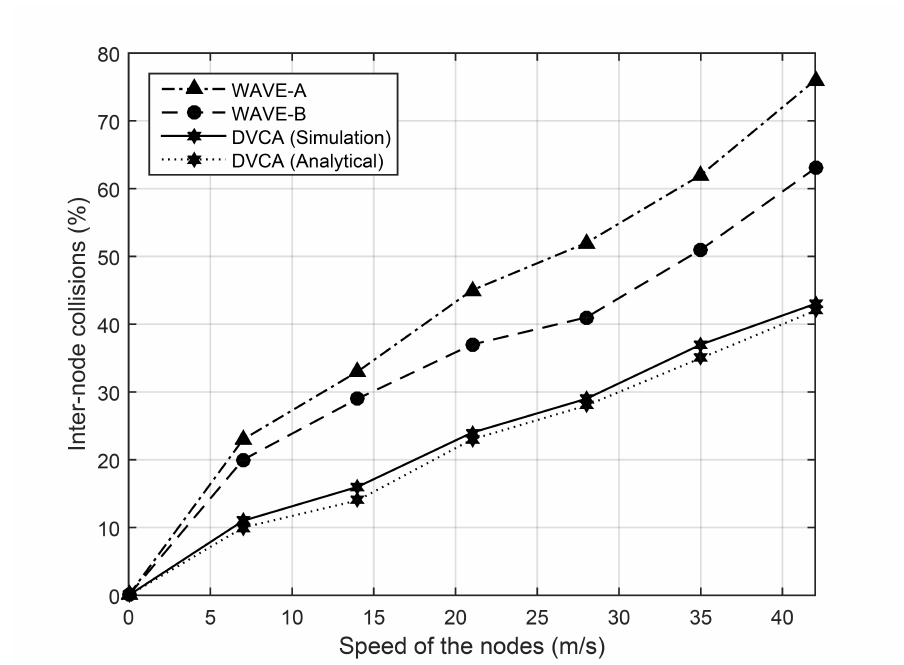
Figure 15. The effect of relative speed on